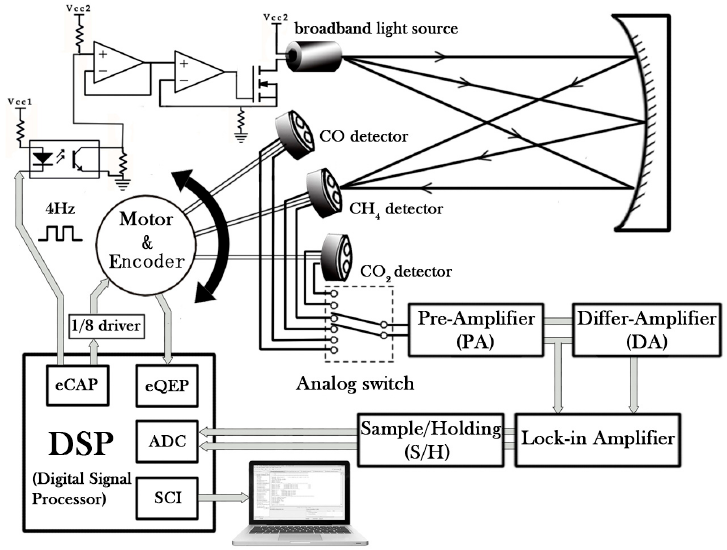
Figure 1. Schematic of the multi-gas sensor system using a broadband light source and a three dual-channel pyroelectric detector system.